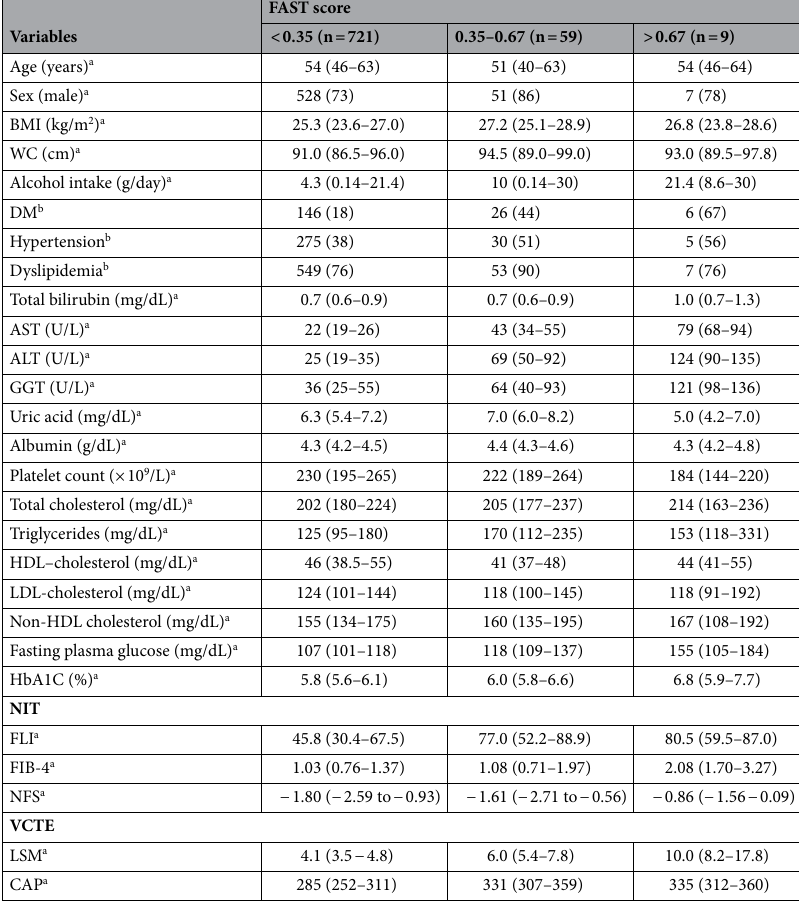
Table 2. Comparison of the clinical characteristics of MAFLD patients by FAST score. ALT: alanine aminotransferase; AST: aspartate aminotransferase; BMI: body mass index; CAP, controlled attenuation parameter; DM: diabetes mellitus; FAST: FibroScan-aspartate aminotransferase; FIB-4: fibrosis-4; FLI: fatty liver index; GGT: gamma-glutamyltransferase; HDL: high-density lipoprotein; LDL: low-density lipoprotein; LSM, liver stiffness measurement; MAFLD: metabolic dysfunction-associated fatty liver disease; NFS: NAFLD fibrosis score; NIT: noninvasive test; VCTE: vibration controlled transient elastography; WC: waist circumference. a Median (interquartile range), b number